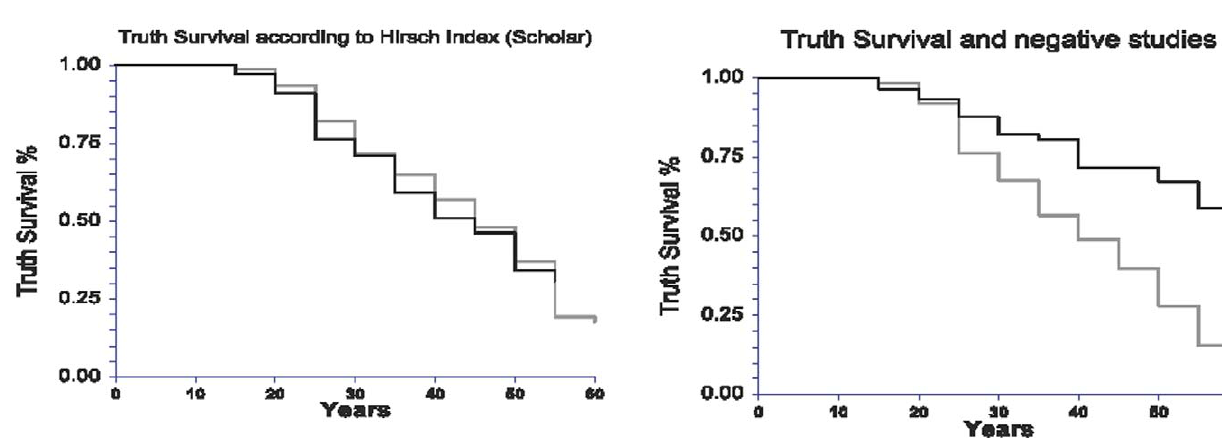
Figure 4. Survival of 474 conclusions according to the negative or positive finding. There was a significant difference between 50 years survival, 72 6 12% (black line) and 40 6 3% (grey line), respectively (P ,